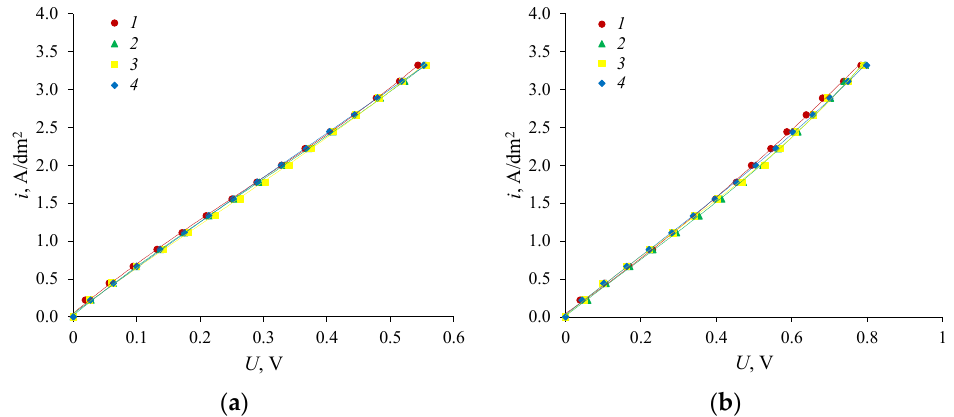
Figure 11. Current-voltage characteristics of the anion-exchange membrane Ralex AMH ( a ) and anion-exchange membrane MA-40L ( b ) at different speeds of circulation of solutions: For initial membrane: 1 —2.5 cm/s, for membrane after use in electrodialysis processes: 2 —0.5 cm/s, 3 —1.5 cm/s, 4 —2.5 cm/s. Each curve was calculated by averaging over the overvoltage of three-time measurements of current-voltage characteristics.